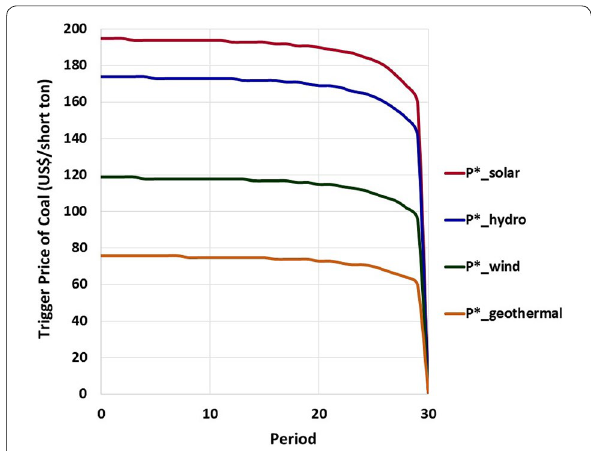
Fig. 2 Trigger coal price dynamics for various renewable energy sources at the baseline scenario. Note P * is the trigger price of coal at each period of investment (see Additional file 1: Table S4 for simula- tion result)